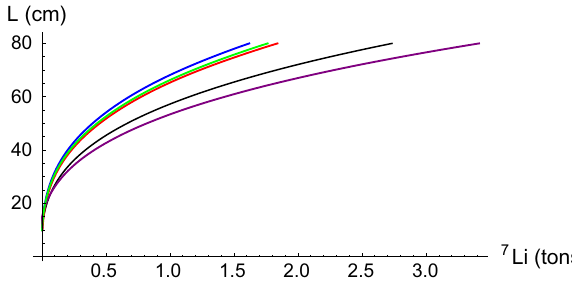
Fig. 3 The target station radius, including the detector and the con- verter as a function, of the 7 Li mass. The black, blue, red, purple and green curves represent the LiOD, LiOD · D 2 O, solution, metallic Li and FLiBe converters respectively. The radius is divided by two in the case of the solution, for clarity of the